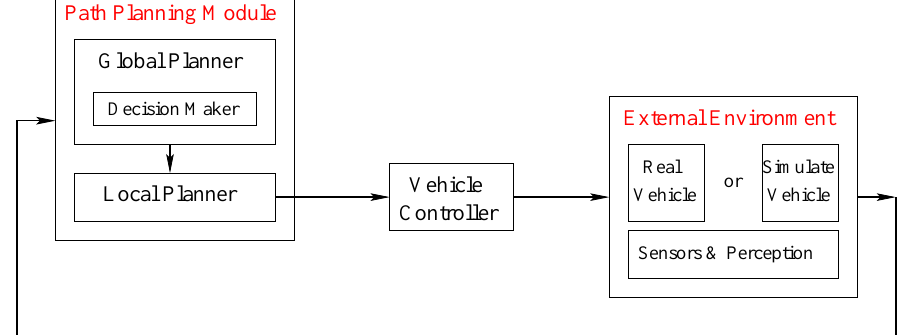
Figure 1. Path Planner Structure (global planner, decision maker, and local planner) and its relationship with the vehicle and the external